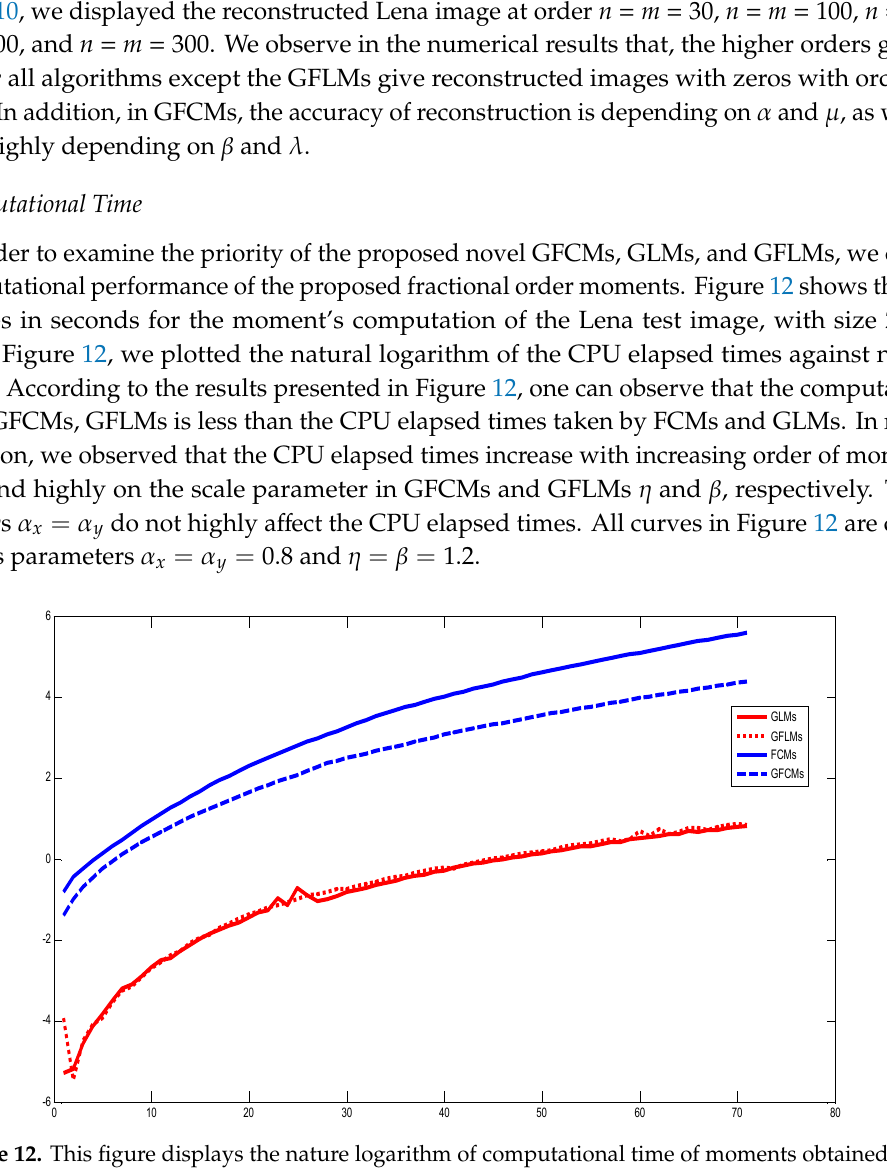
Figure 12. This figure displays the nature logarithm of computational time of moments obtained from different proposed GFCMs, GLMs, GFLMs, and FCM algorithms.